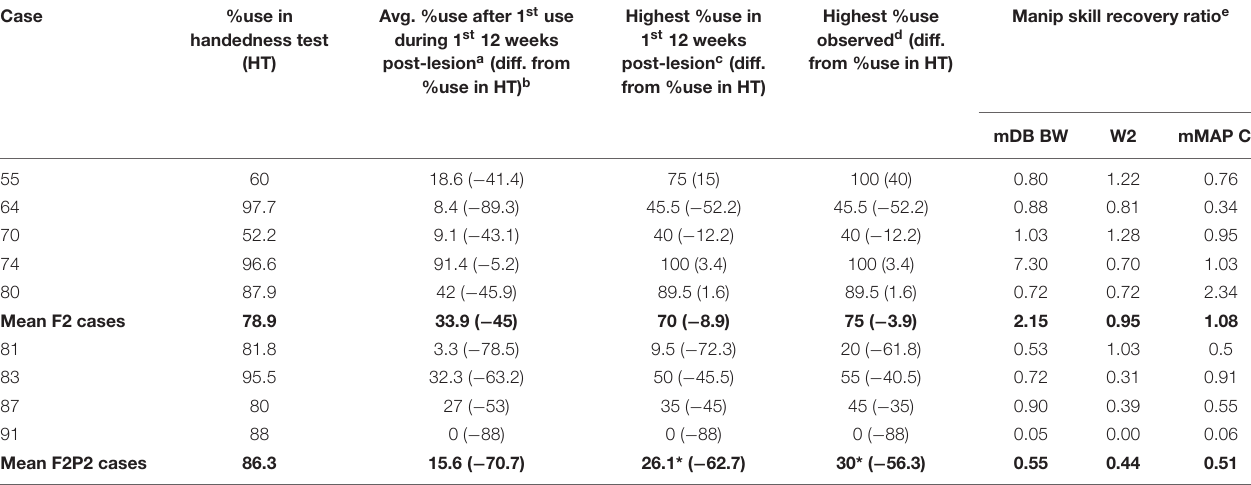
TABLE 3 | %use of the contralesional hand in the RU task and recovery of manipulation skill during the first 12 post-lesion weeks. Case